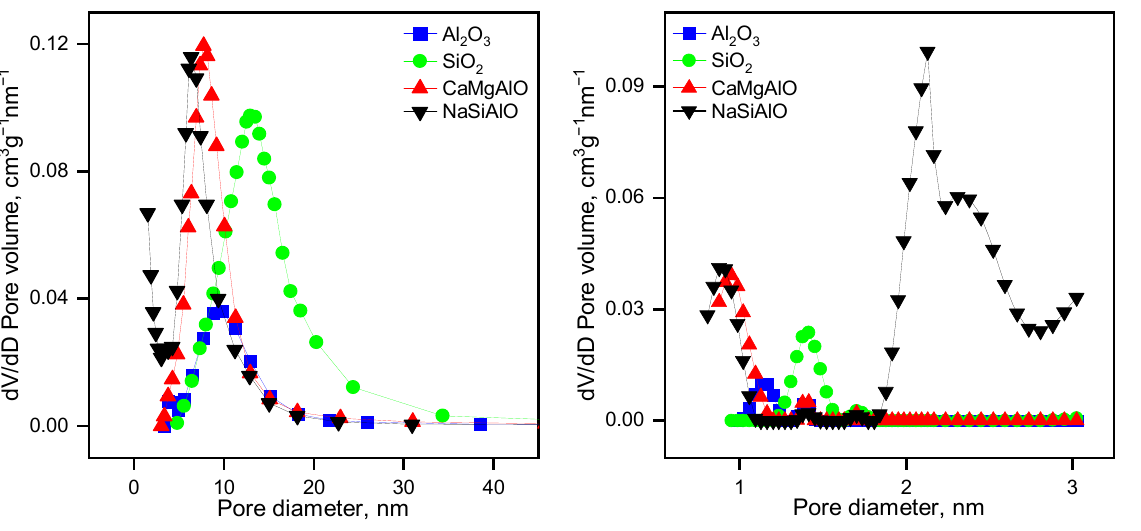
Figure 1. Meso- ( left ) and micro- ( right ) pore size distributions for the samples of the supports. Table 1. The textural properties of the supports of the catalysts derived by the N 2 low-temperature adsorption-desorption